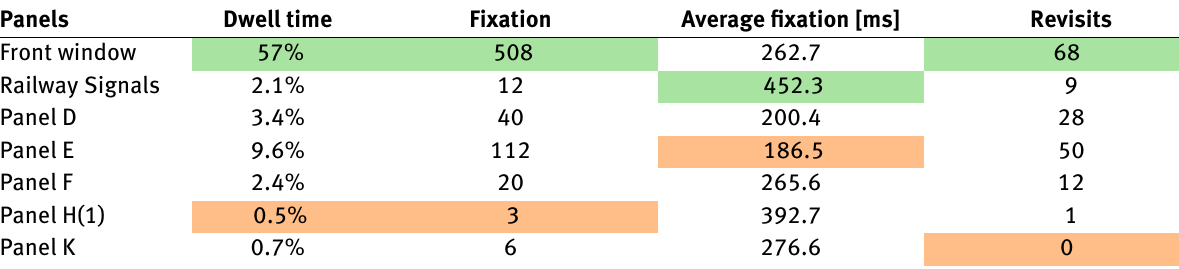
Table 2: KPI at the section Žilina-Horný Hričov Panels